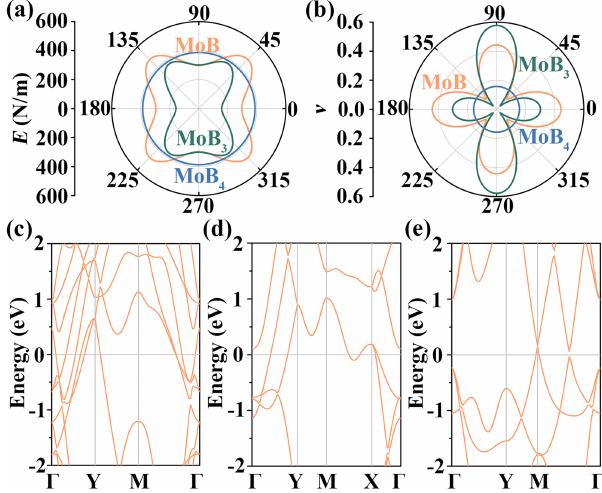
Fig. 3 Structural and electronic properties. a Young ’ s moduli, b Poisson ’ s ratios, and c – e electronic band structures of the MoB x ( x = 1, 3, and 4) monolayers.